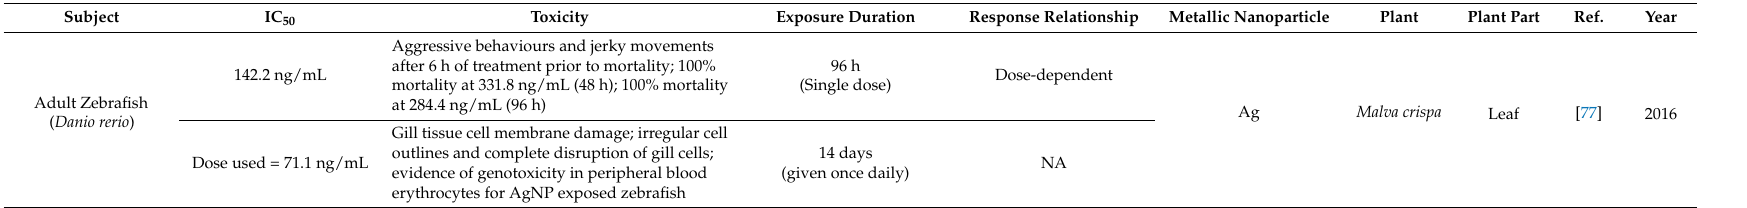
Table 3. The cytotoxicity of plant-mediated syntheses of metallic nanoparticles on animals (in